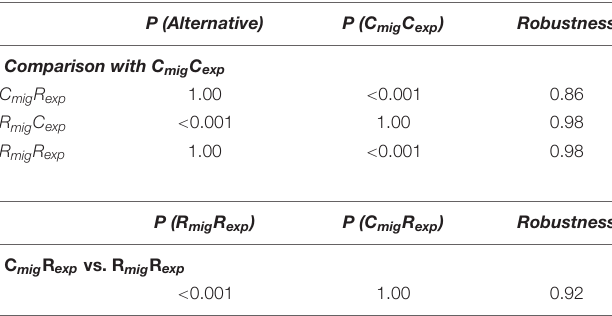
TABLE 6 | Posterior probabilities calculated through Bayes factors for speciation models comparing temporal patterns of population expansion and migration (recent vs. continuous) tested by ABC